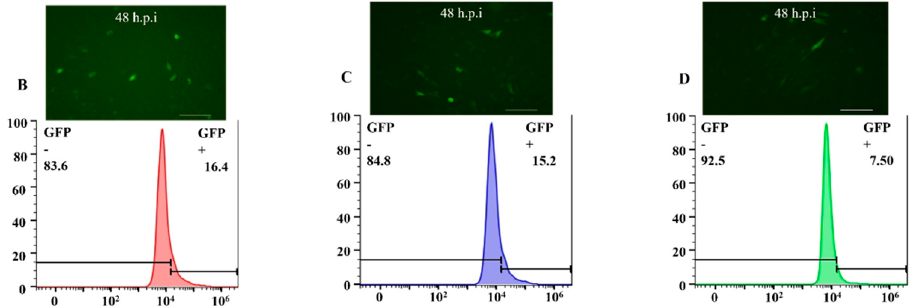
Figure 7. Efficiency of transducing BHK-21 cells by AcBV with envelope modification. ( A ) Measure the number of BHK-21 cells expressing green fluorescence by flow cytometry. ( B ) Measure the number of BHK-21 cells expressing green fluorescence by flow cytometry, which the AcBV- Δ gp64- pie1-invasin-64orf-p64-gfp-ires-gp64 infected for 48 h. ( C ) Measure the number of BHK-21 cells expressing green fluorescence by flow cytometry, which the AcBV- Δ gp64-pie1-vsvg-p64-gfp-ires-